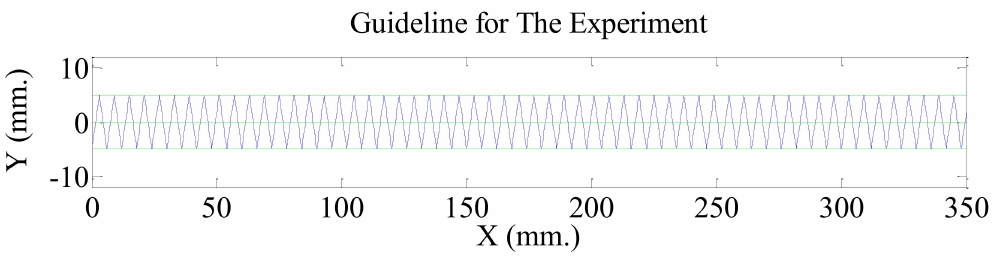
Figure 7. Guideline for the